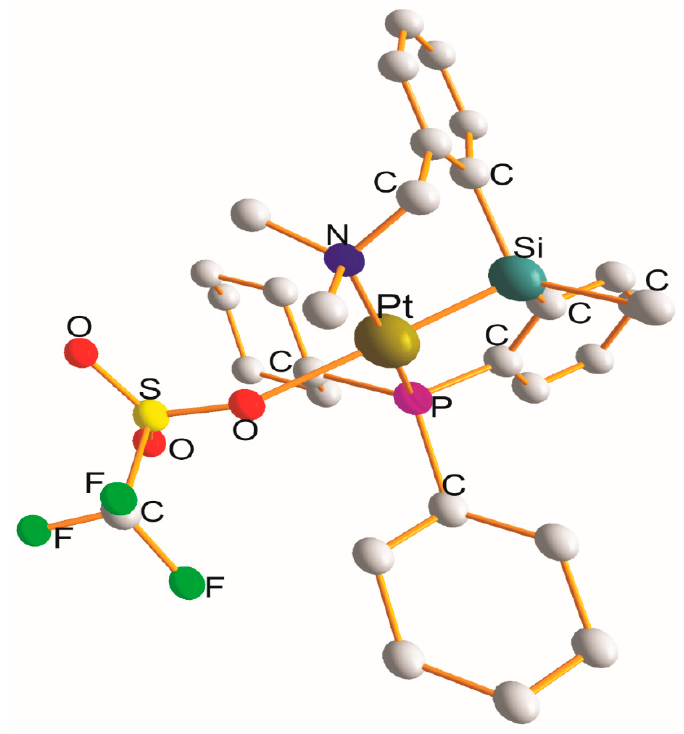
Figure 5. Structure of [Pt{ κ 3 –cyh 2 P 1 (C 6 H 4 )Si 1 (CH 3 )(C 7 H 6 )N 1 (CH 3 ) 2 }(OSO 2 CF 3 )] [28]. As can be seen (Tables 1 and 2), organomonophosphines as heterotridentate ligands used (except for the P atom) a wide variety of heteroatoms for coordination to Pt(II) atoms. There are twenty four Pt(II) complexes which crystalized in three crystal classes: mono- clinic (16 examples), triclinic (5 examples) and orthorhombic (3 examples). Each